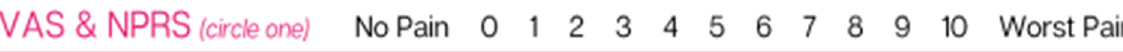
Table 1. Percent change analysis for initial and final NPRS and WOMAC